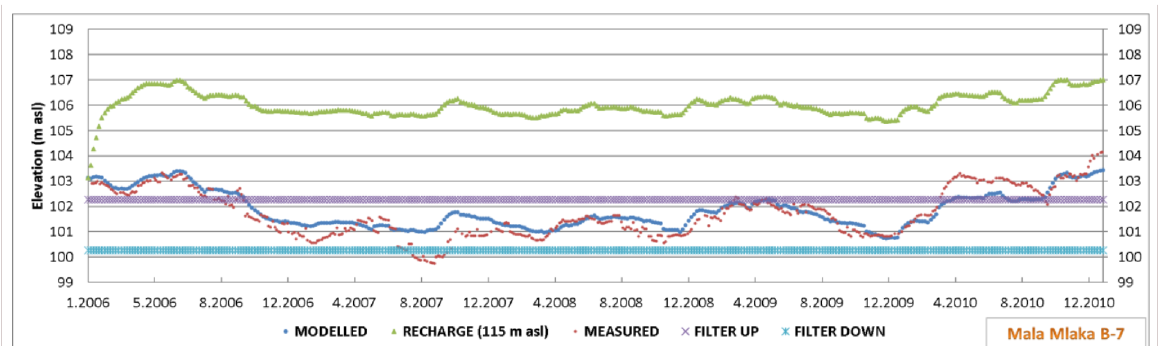
Figure 15. Influence of the MAR variant with a water level of 115 m a.s.l. on well B-7 of the Mala Mlaka water pumping station.